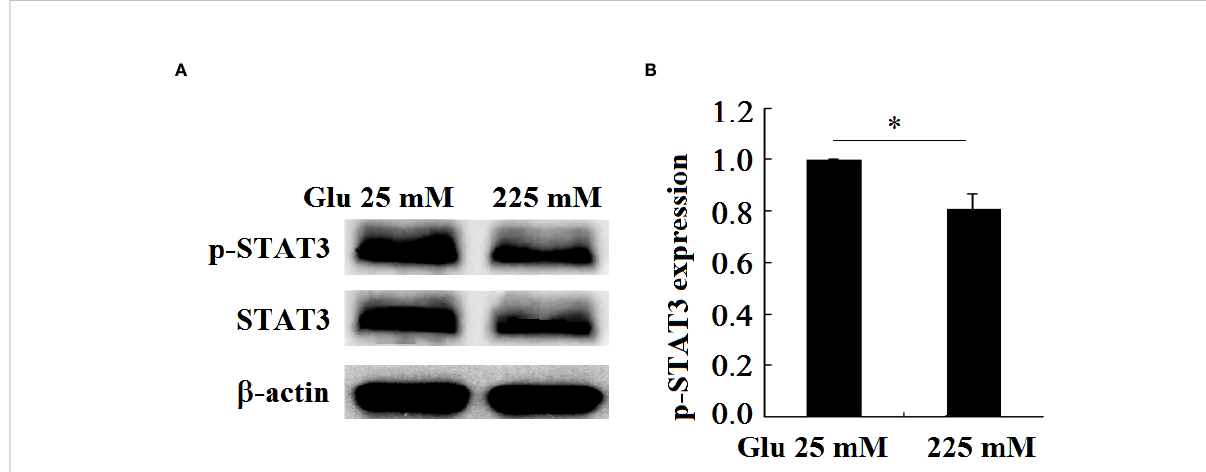
FIGURE 10 P-STAT3 and STAT3 expression in hippocampal neurons decreased under high glucose stimulation, * P < 0.05. (A) Western blot to detect the expression of STAT3 phosphorylation. (B) Grayscale analysis of the phosphorylation of STAT3.